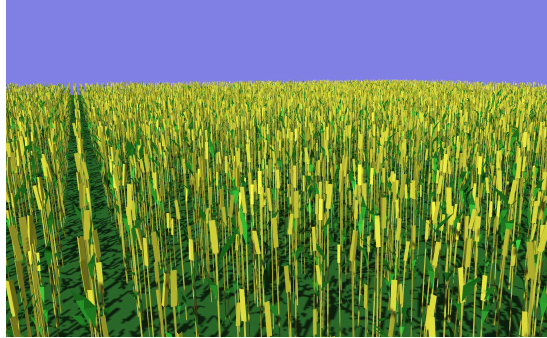
Figure 6: Close-up view of a procedurally generated crop field model.